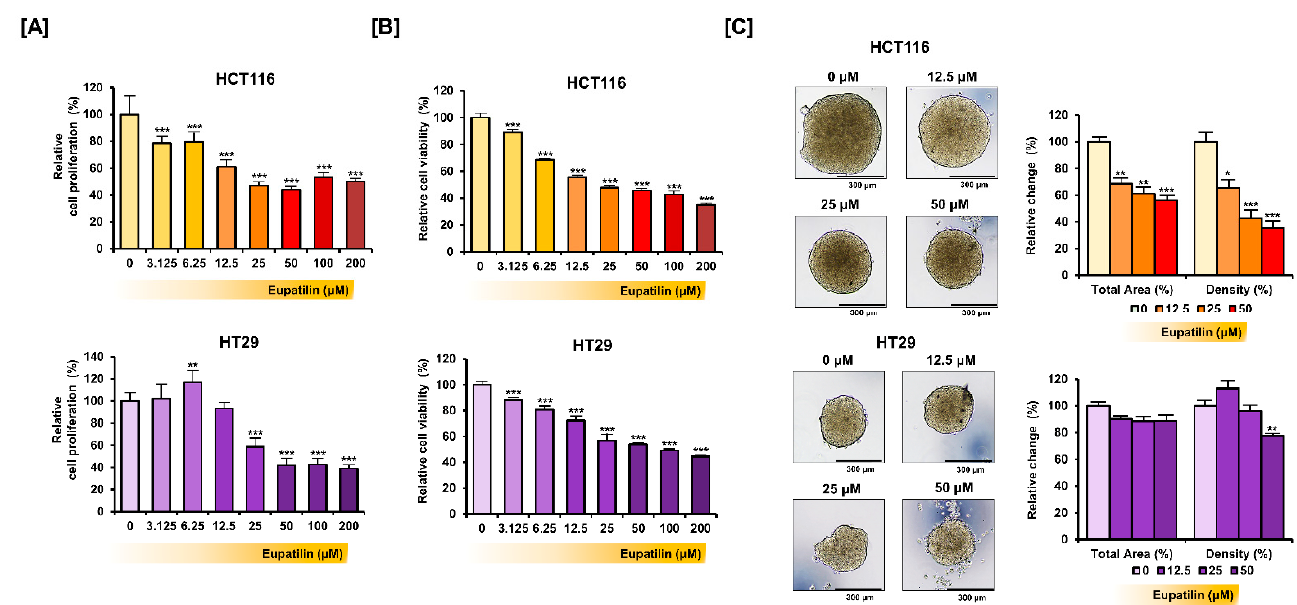
Figure 1. Eupatilin inhibits colon cancer cell growth. ( A ) Dose-dependent effects of eupatilin on HCT116 and HT29 cell proliferation. ( B ) Dose-dependent effects of eupatilin on HCT116 and HT29 cell viability. ( C ) Bright field images showing the changes in spheroid morphology following eupatilin treatment. The total area and density of the spheroid were calculated using the ImageJ software. Asterisks indicate a significant change after eupatilin treatment (*** p < 0.001, ** p < 0.01 and * p < 0.05).